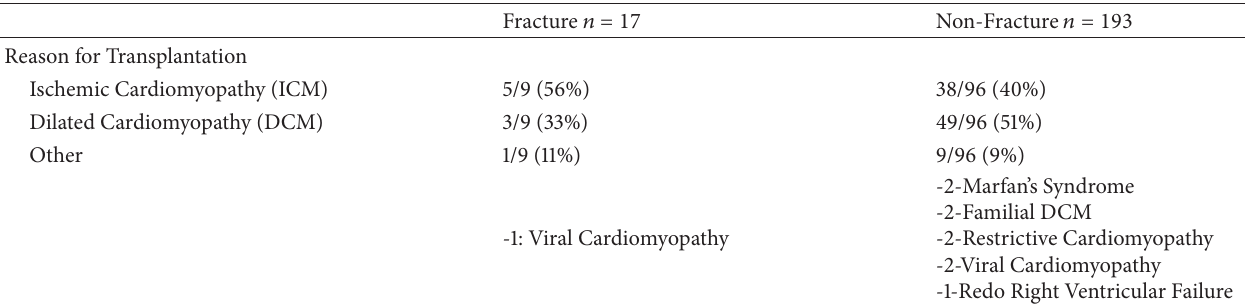
Table 4: Comparison of reasons for transplantation in those with fractures versus no fractures in the heart transplant